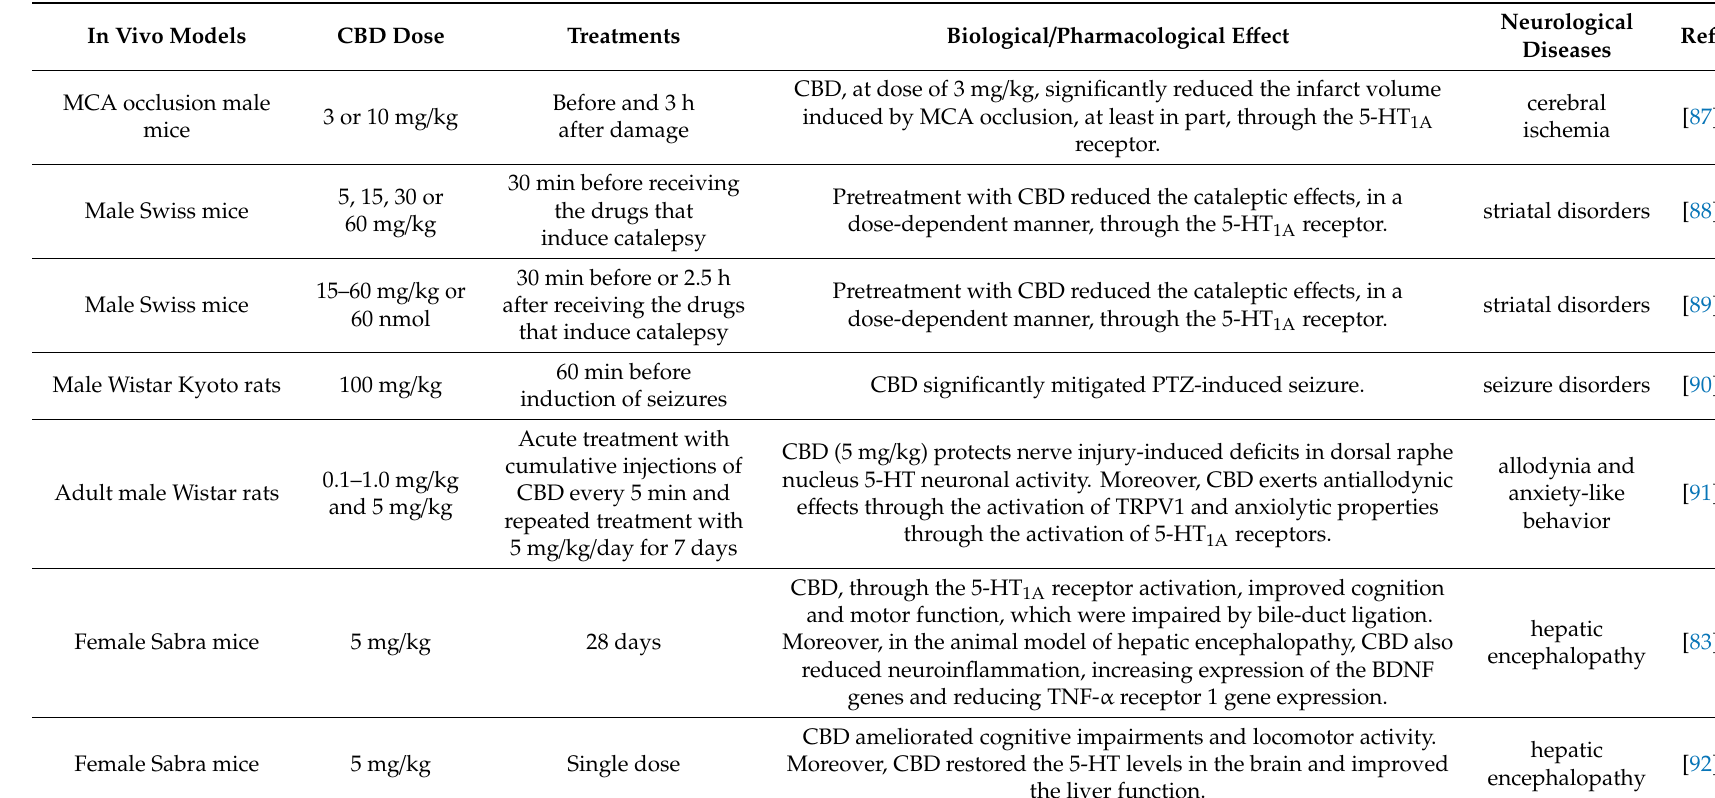
Table 2. Neuroprotective e ff ects of CBD in di ff erent neurological diseases through the activation of the 5-HT 1A